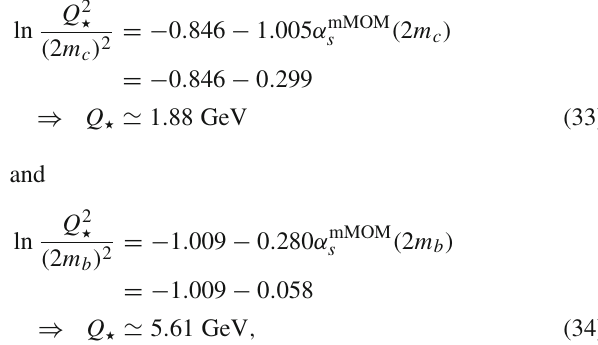
-ratio by using the [1/1]-type PAA Q